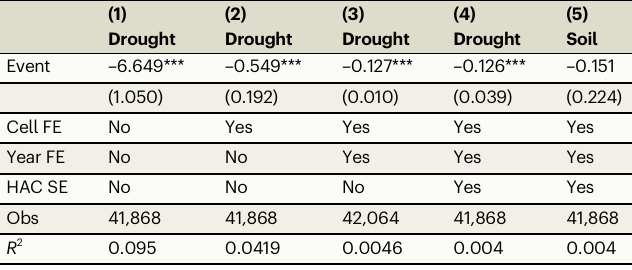
Table 1 | Effects of drought events (columns 1 – 4) and soil degradation (column 5) on population